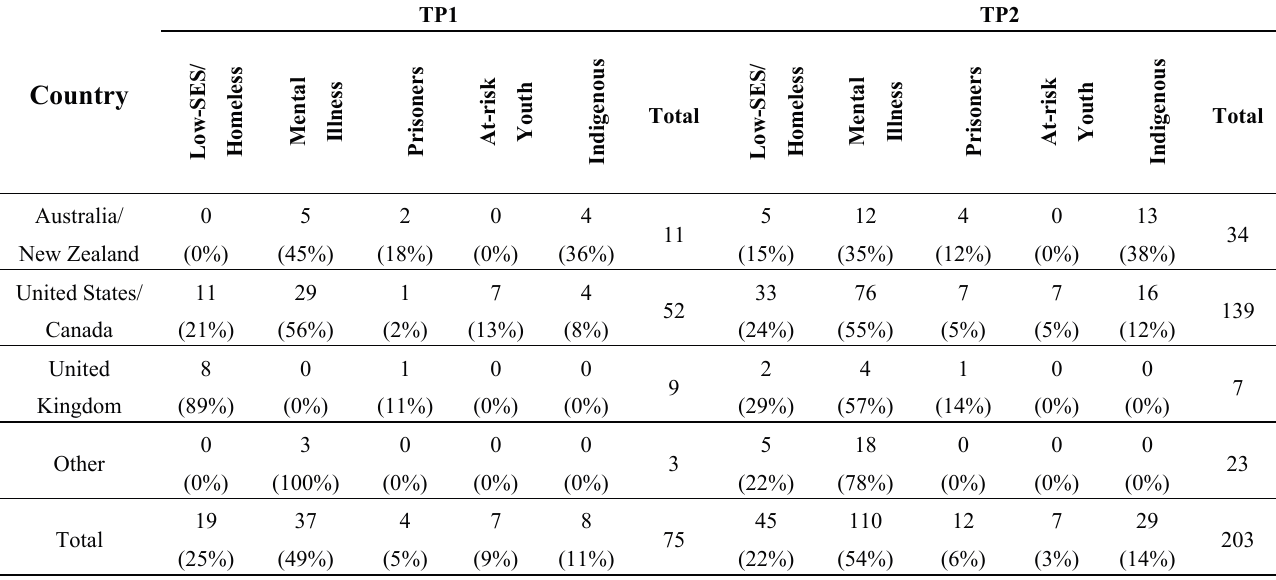
Table 2. Research output by country and population group across time periods represented by number of publications and proportion (%) output.